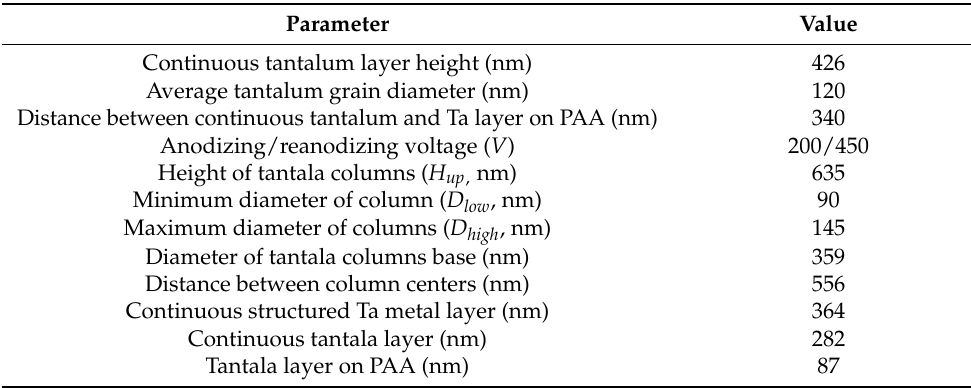
Table 3. Morphological parameters of second-level nanostructures.